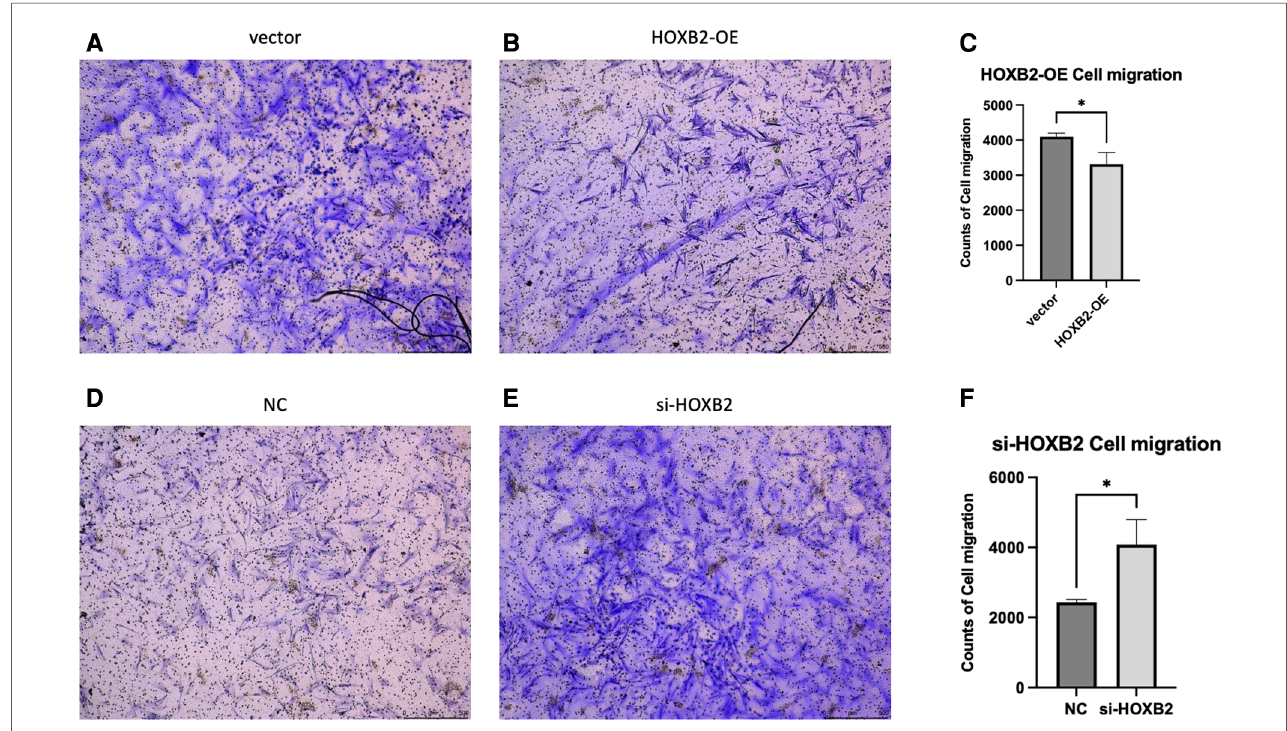
FIGURE 5 ( A – C ) overexpression of HOXB2 inhibited ADSC migration. ( D – F ) Knockdown of HOXB2 expression have enhanced ADSC migratory ability.